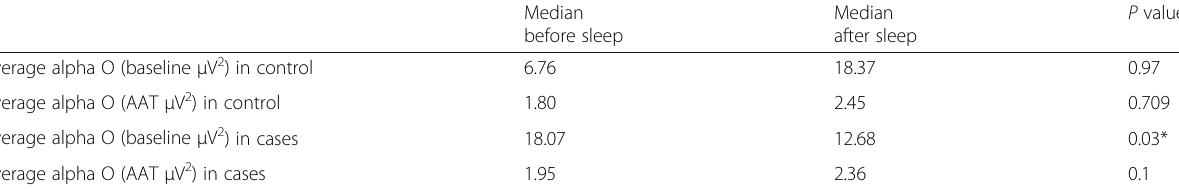
Table 2 Comparison of occipital alpha power baseline and AAT within each of cases and controls